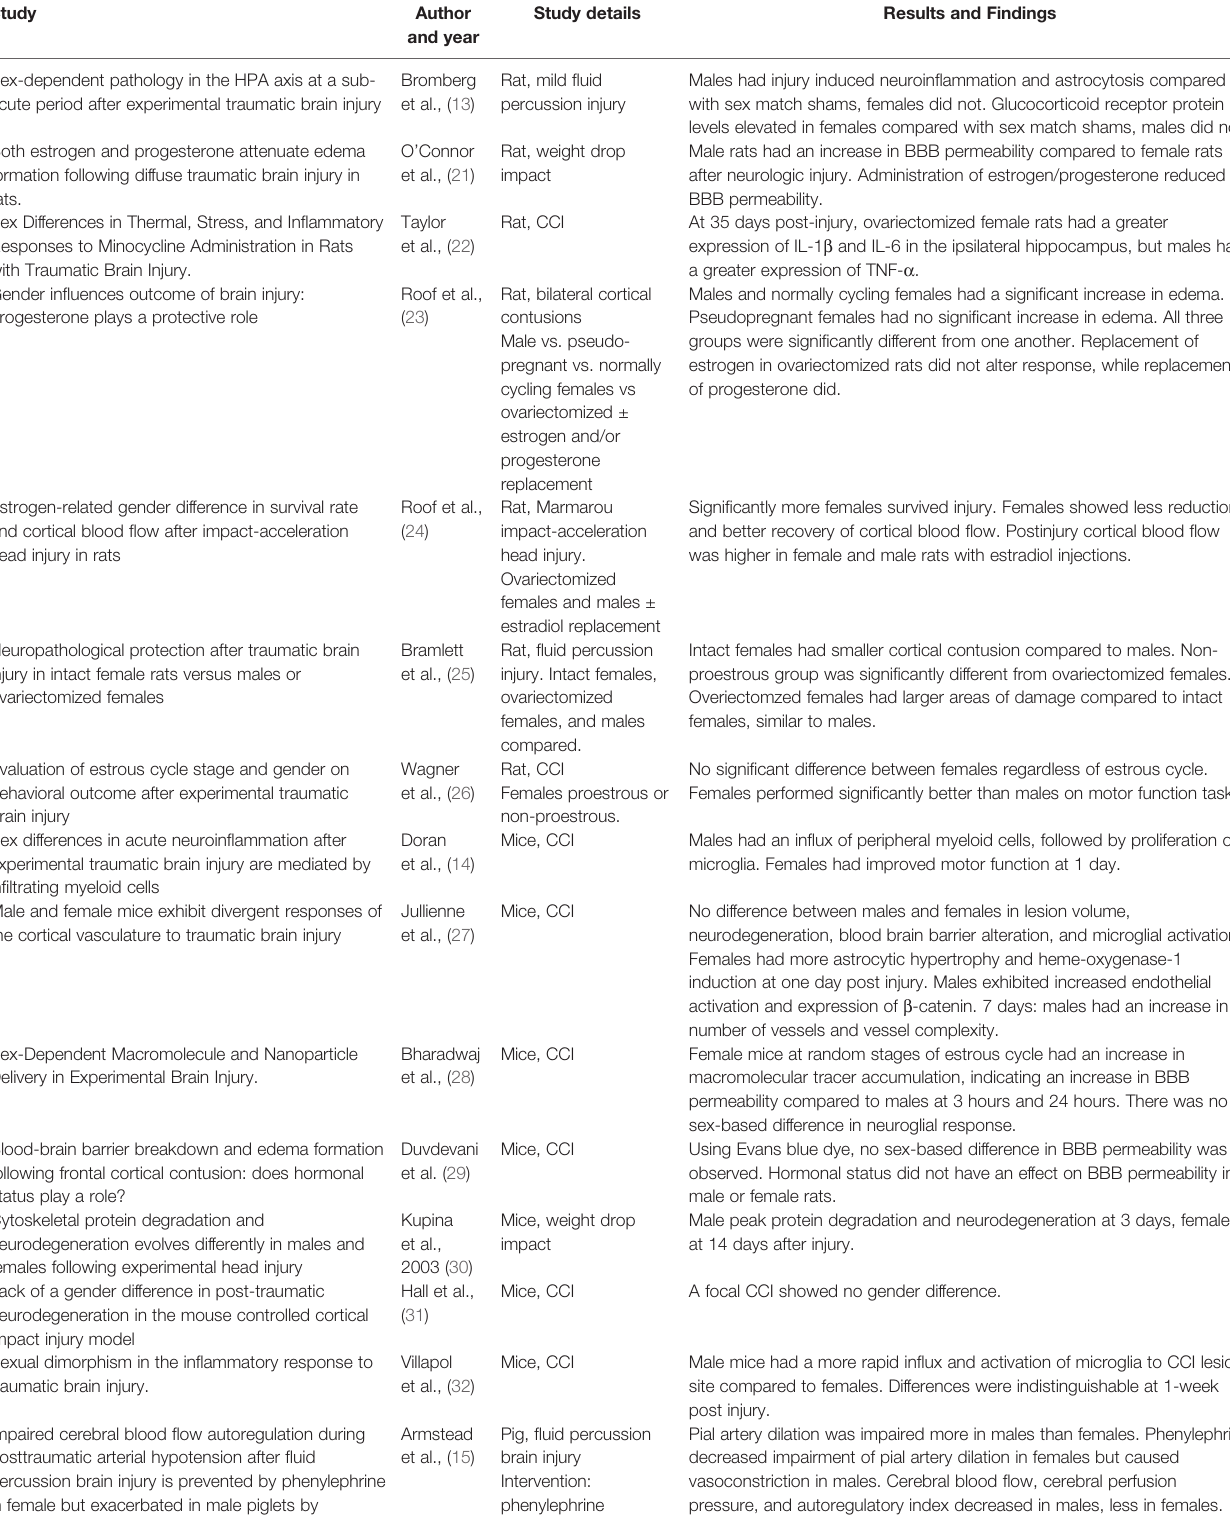
TABLE 2 | Pre-clinical animal studies of sex-based